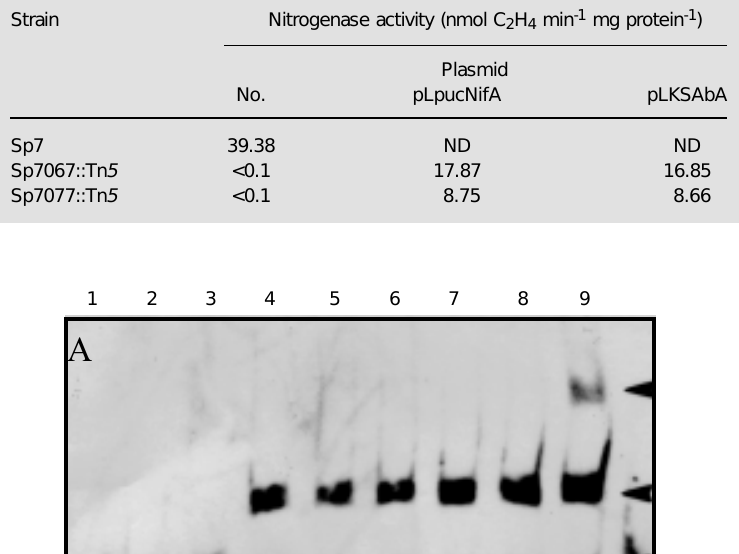
Table 4 - Nitrogenase activity of A. brasilense .